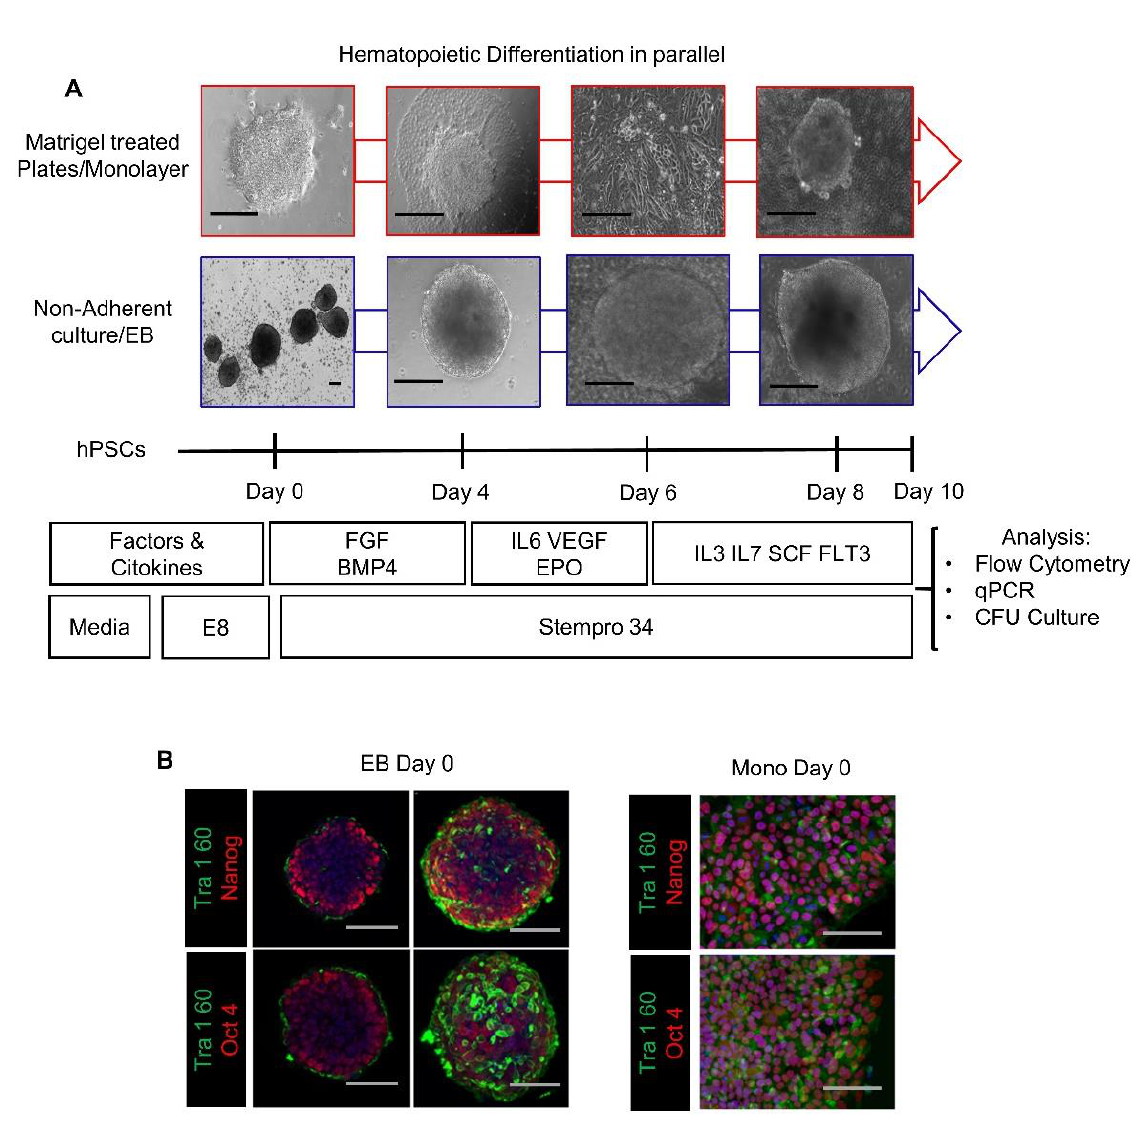
Figure 2. Comparison of the pluripotency of hPSCs in 2D/monolayer and 3D/EB culture systems. ( A ) Experimental procedure of in vitro differentiation in parallel settings showing representative phase-contrast images of cells at Day 0, Day 4, Day 6 and Day 8. ( B ) Immunofluorescence analysis of 3D/EBs clones and their cross-sections, and 2D/Monolayer cells, stained by antibodies to Tra-160, Oct4 and NANOG. Scale Bars: EB: 100μ M, Monolayer: 100μ M.